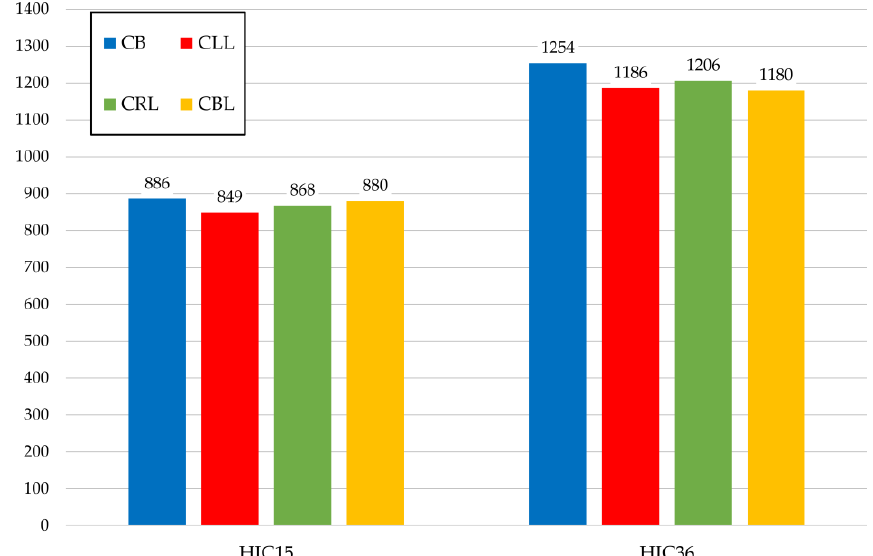
Figure 19. Head Injury Criterion (HIC) comparison.